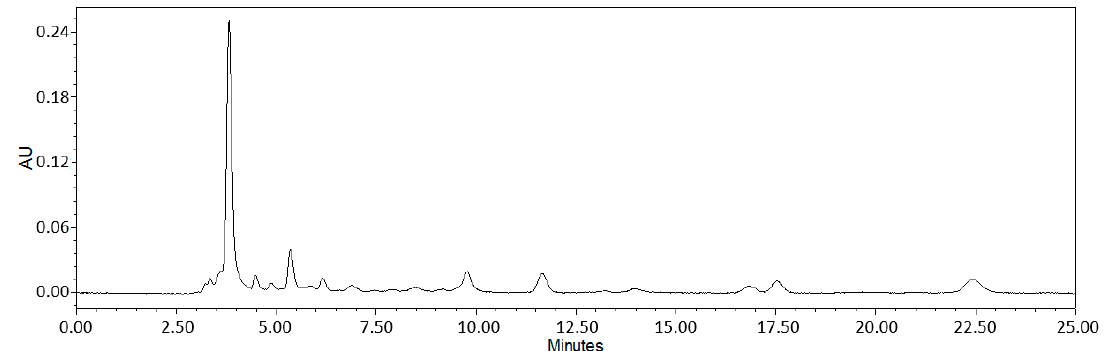
Figure 1. High-performance liquid chromatography (HPLC) spectrum analysis: HPLC chromatogram of the wild garlic leaf lyophilisate (WGLL) reporting one major peak at 3.8 min.